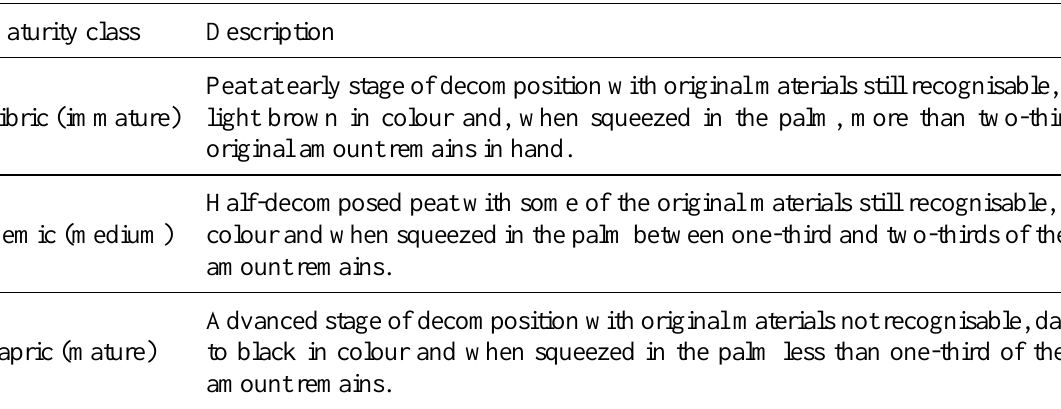
Table 1. The simplified field method for determination of ‘peat maturity’ derived for Indonesian peatlands, after Agus et al .